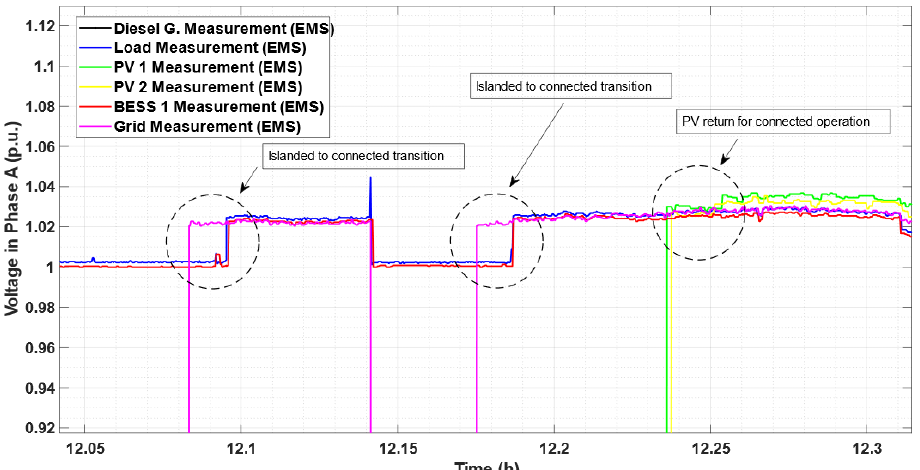
Figure 15. The voltage of microgrid components, reconnection